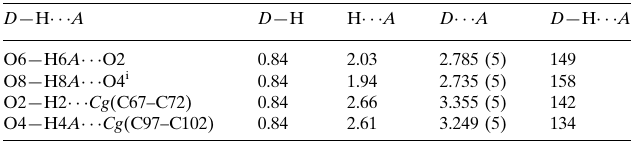
Hydrogen-bond geometry (A˚ , (cid:2)